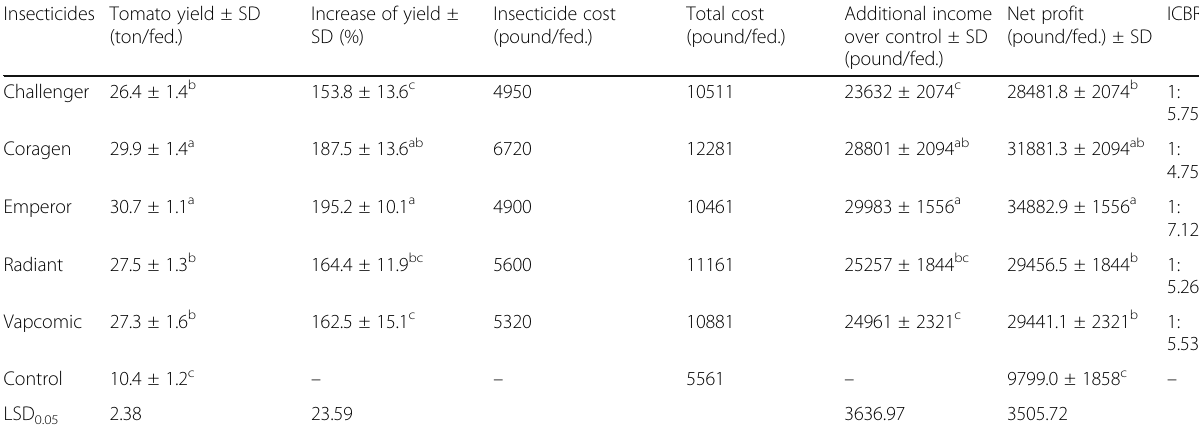
Table 9 Effect of the tested insecticides on the marketable yield of tomato plants Insecticides Tomato yield ± SD Increase of yield ± (ton/fed.) SD